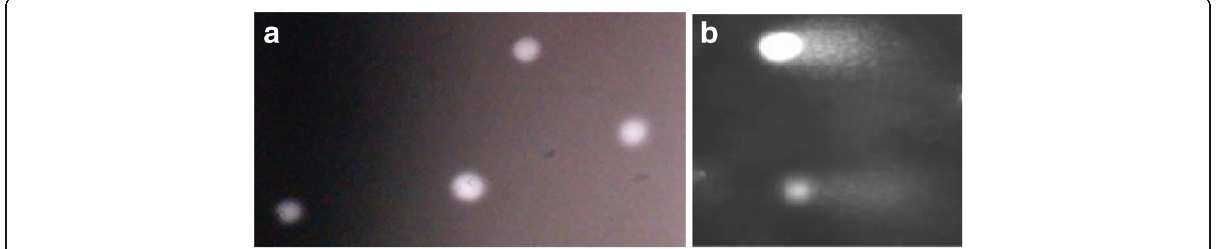
Fig. 1 White spots [( a ) comets without tails ( b ) comets with tails] of the comets that were detected in genotoxicity test. The software